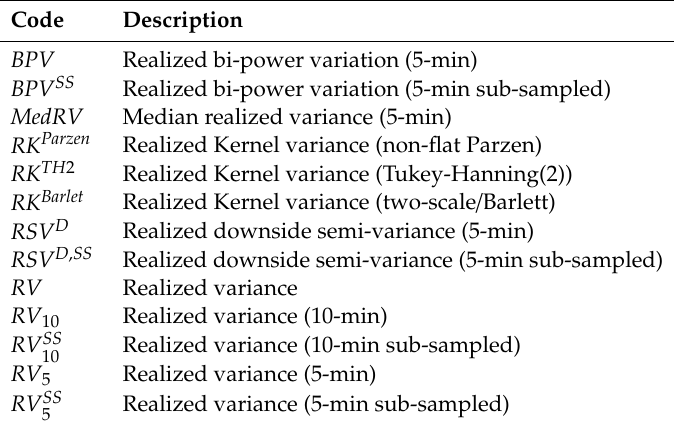
Table 1. Realized